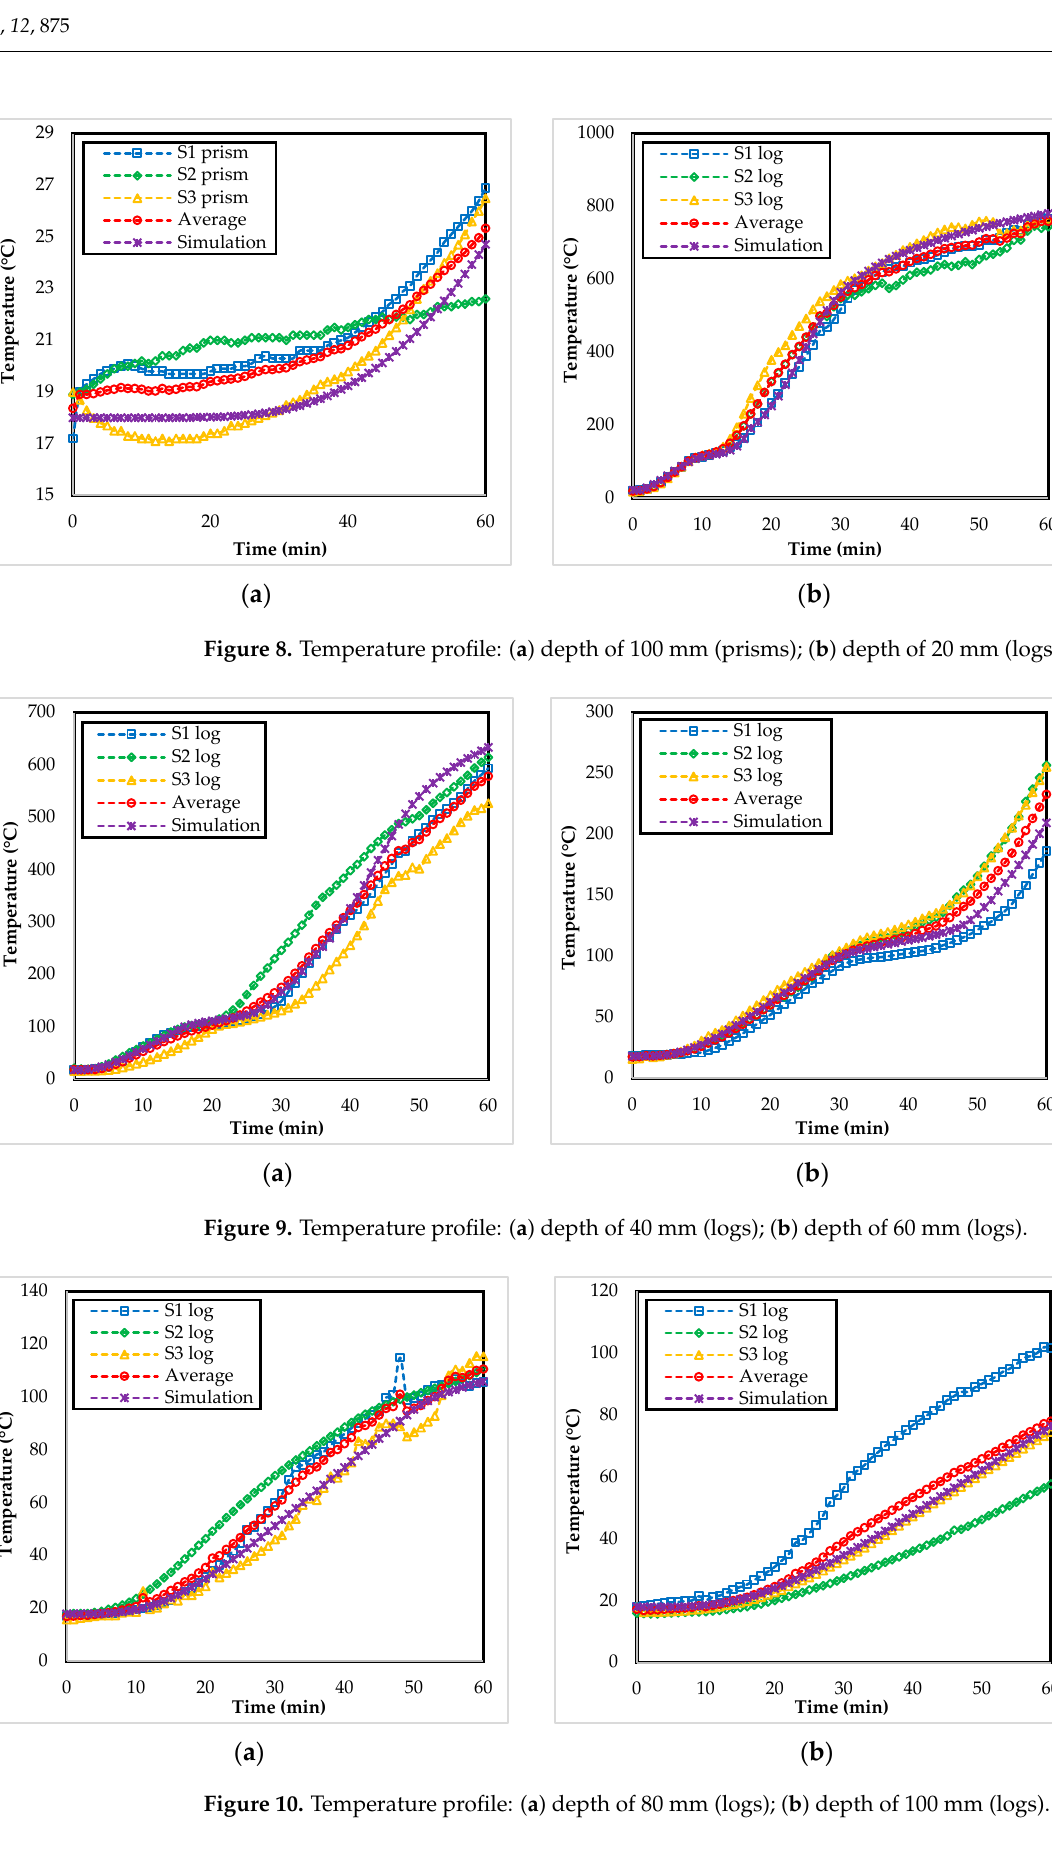
Figure 7. Temperature profile: ( a ) depth of 60 mm (prisms); ( b ) depth of 80 mm (prisms).